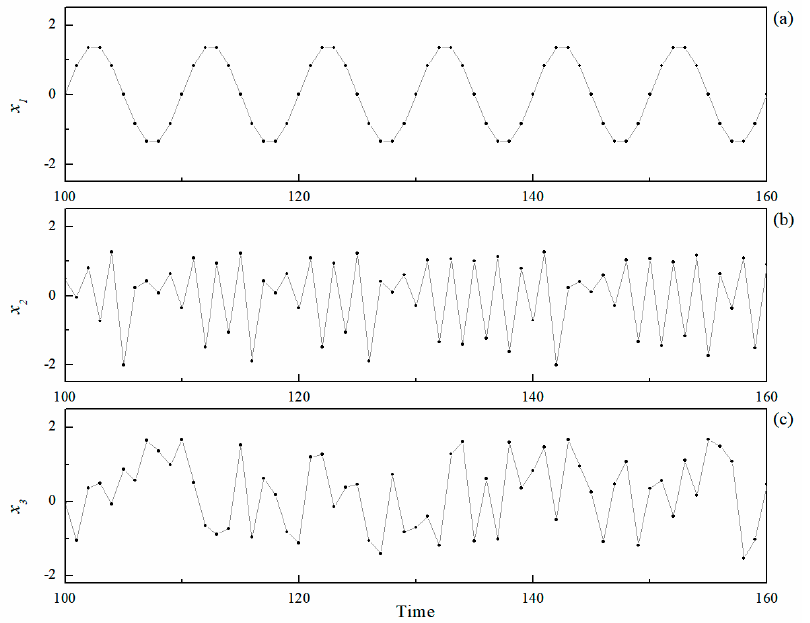
Figure 2. Ideal time series constructed by ( a ) wave function ( x 1 ), ( b ) logistic model ( x 2 ) and ( c ) random number ( x 3 ). Table 2. The quartile values for ideal series.